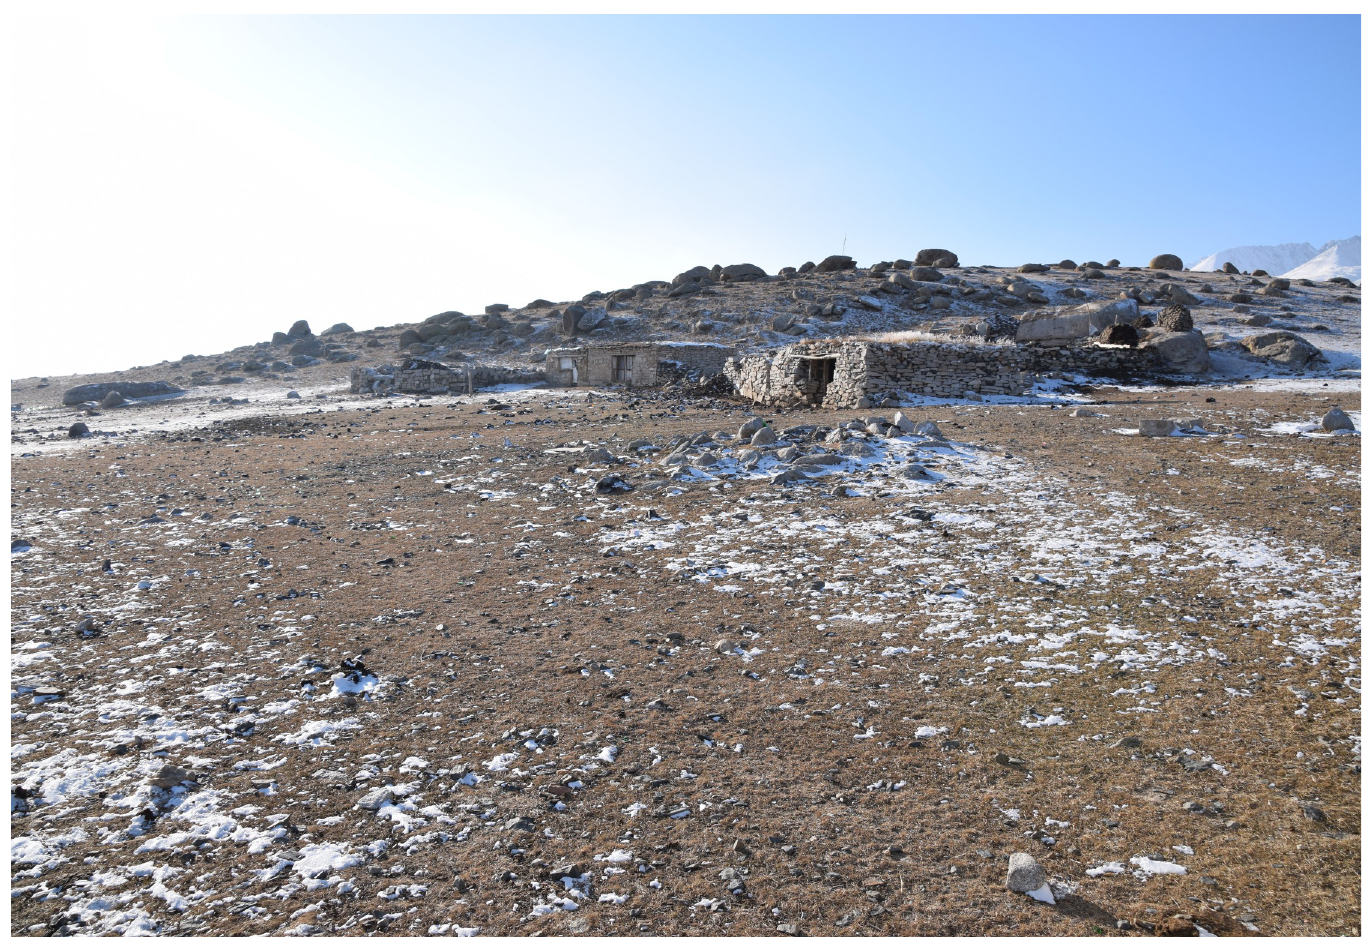
Fig 6. Modern winter camp at Adunqiaolu with little snow cover on the adjacent pasture. The camp faces south towards the sun with a small hill behind (P.